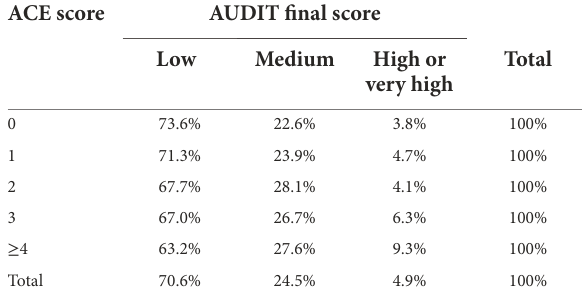
TABLE 4 Distribution of participants according to ACE score and AUDIT final